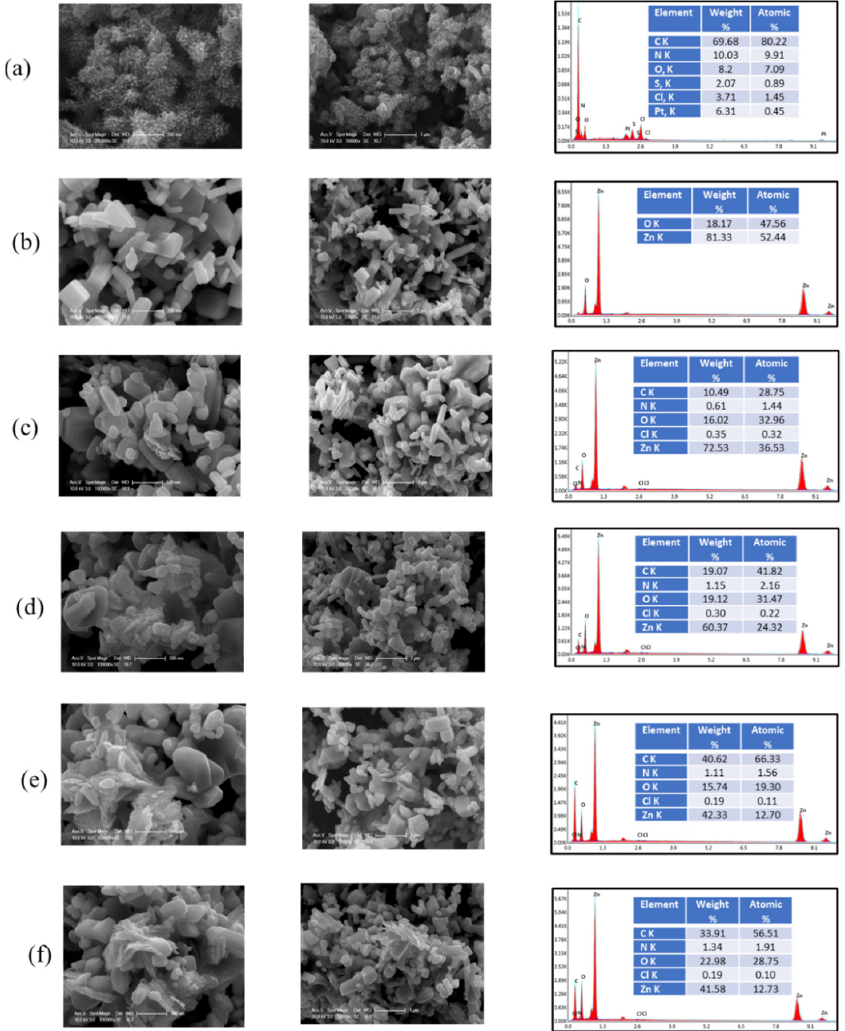
Figure 5. SEM images (left) ×50,000, (right) ×100,000 and Energy Dispersive X-ray Analysis Unit (EDAX) elemental analysis ( a ) PANI-ES, ( b ) ZnO, ( c ) PZI-1, ( d ) PZI-3, ( e ) PZI-6 and ( f ) PZI-9.